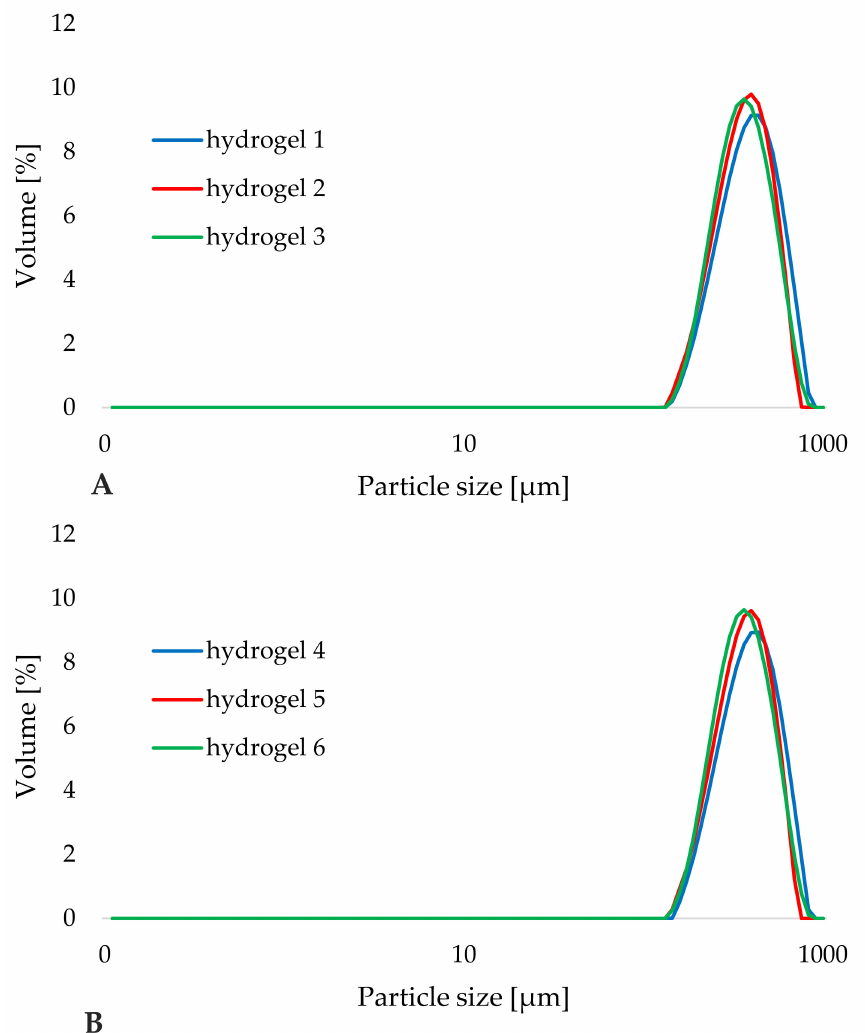
Figure 6. Comparison of particle size distribution curves of the hydrogel formulations: 1–3 ( A ) and 4–6 ( B ) on the day of preparation (day